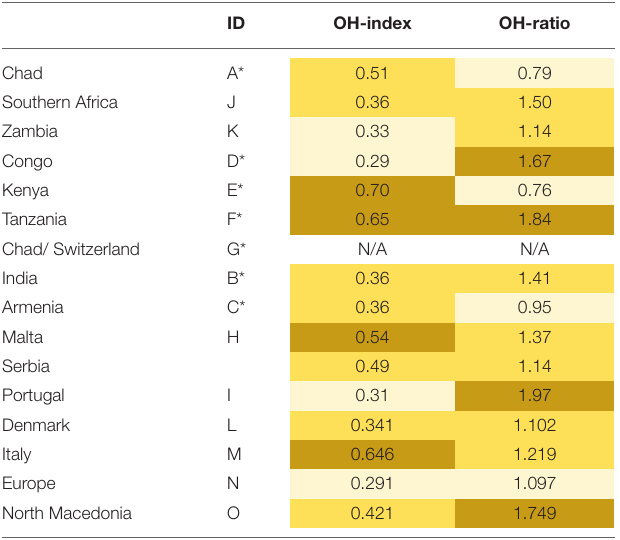
TABLE 5 | One Health index and ratio computed according to the NEOH